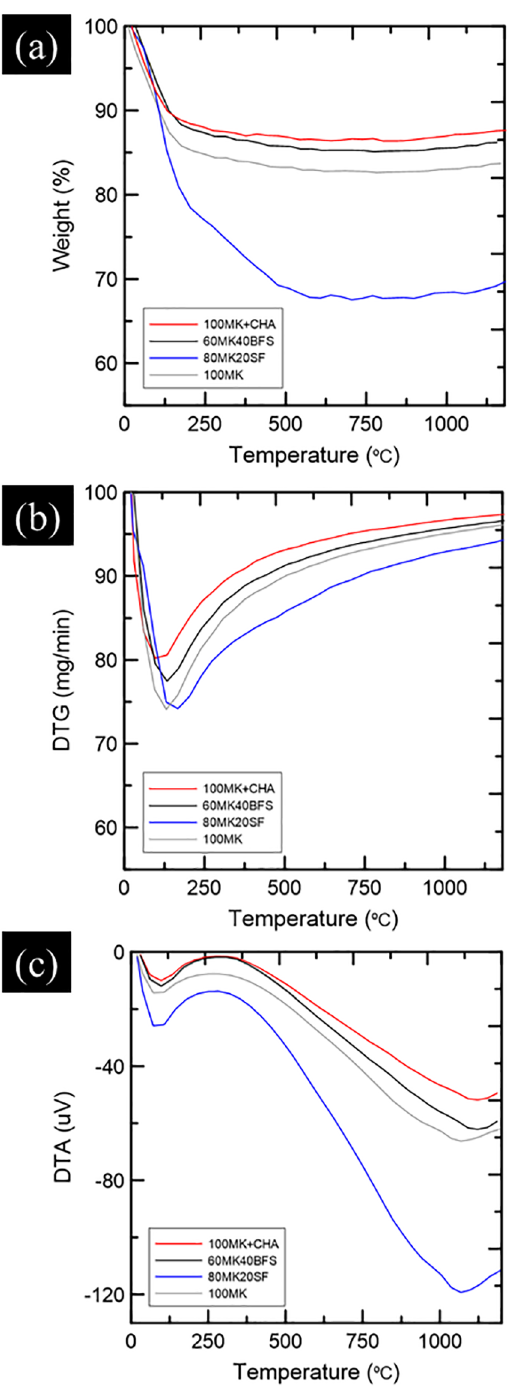
Figure 5. (a) TGA; (b) DTG; and (c) DTA of: 80MK20SF, 60MK40BFS, 100MK and 100MK + CHA.